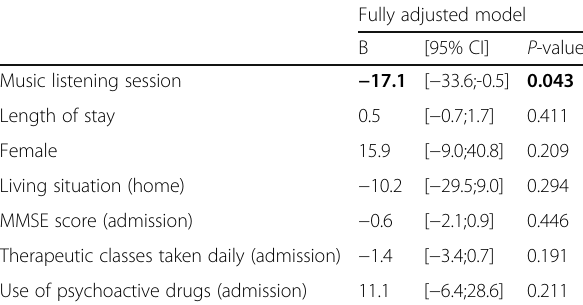
Table 3 Multiple linear regression showing the association between variation a of Morse Morse Fall Scale score and participation to music listening sessions adjusted